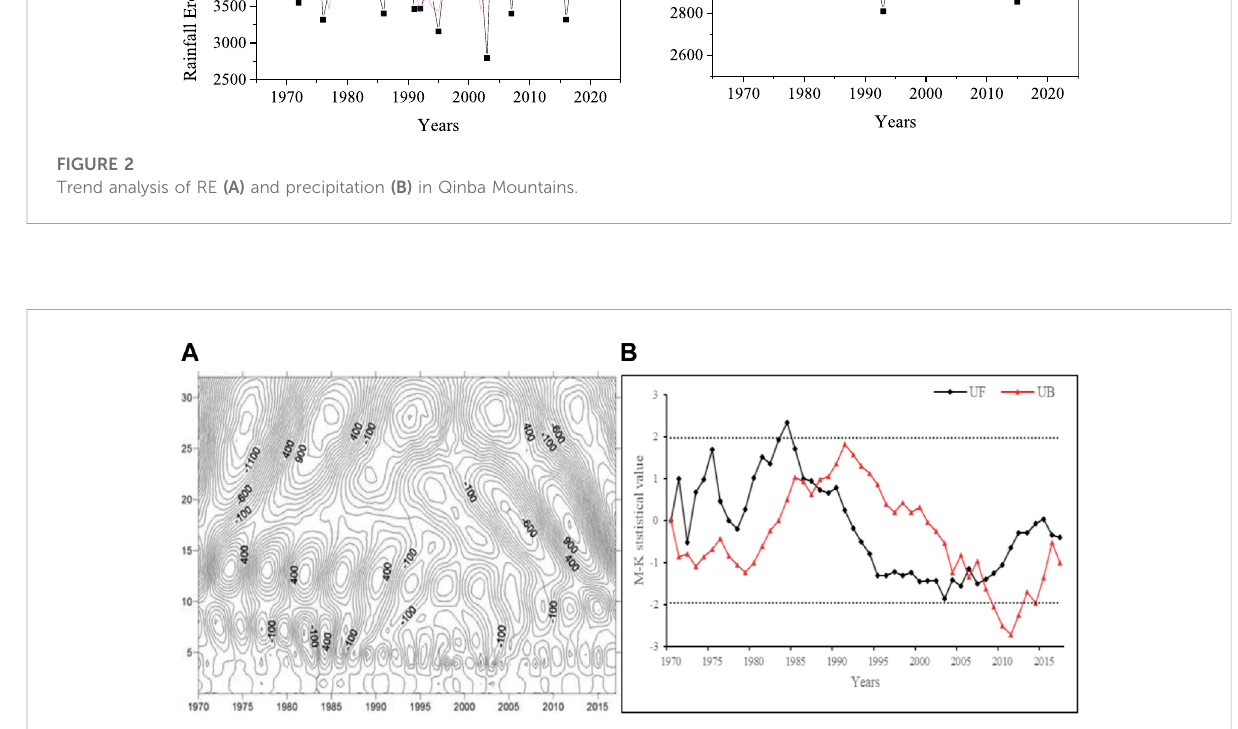
FIGURE 3 Wavelet analysis of RE (A) and M-K test (B) in Qinba